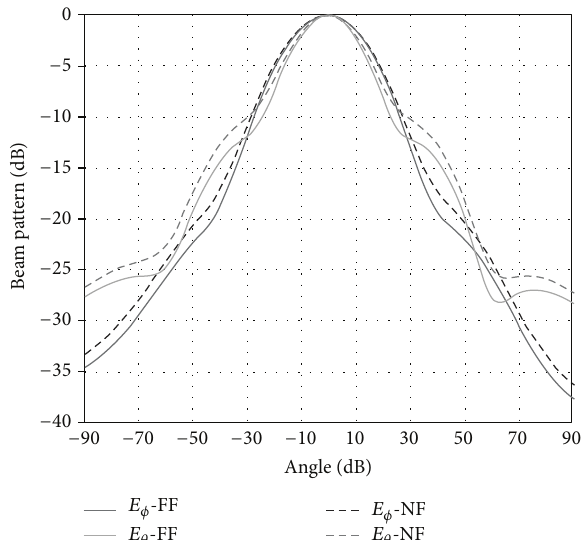
Figure 18: Comparison of near field and far field radiation patterns of conical horn (radius = 4.1cm; semiflare angle 𝛼 0 = 21.09 ∘ ).